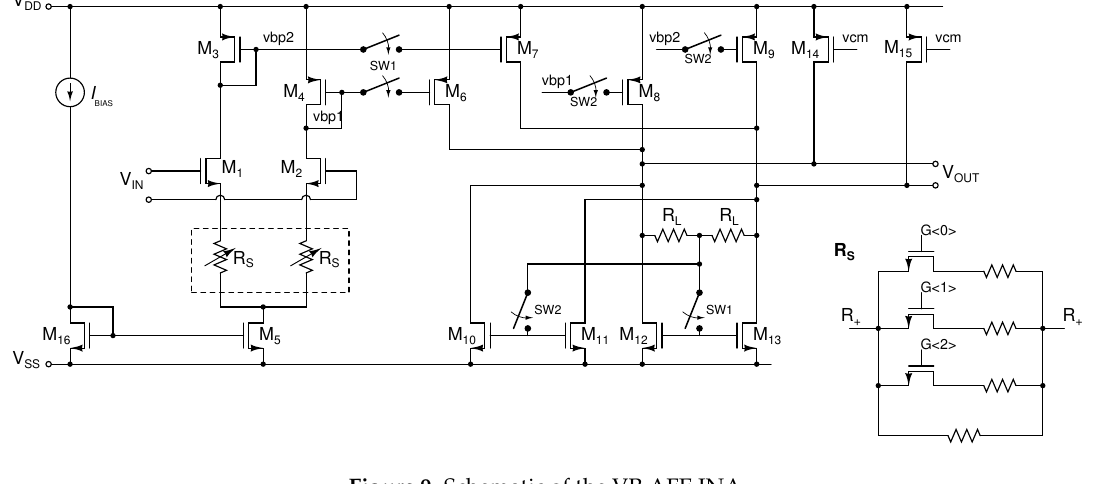
Figure 9. Schematic of the VR AFE